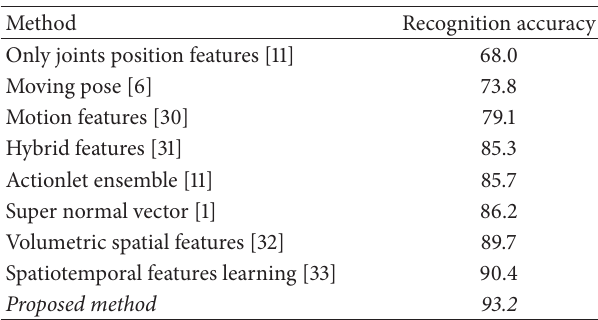
Table 5: Comparison of recognition accuracy of using MSRDaily- Activity3D